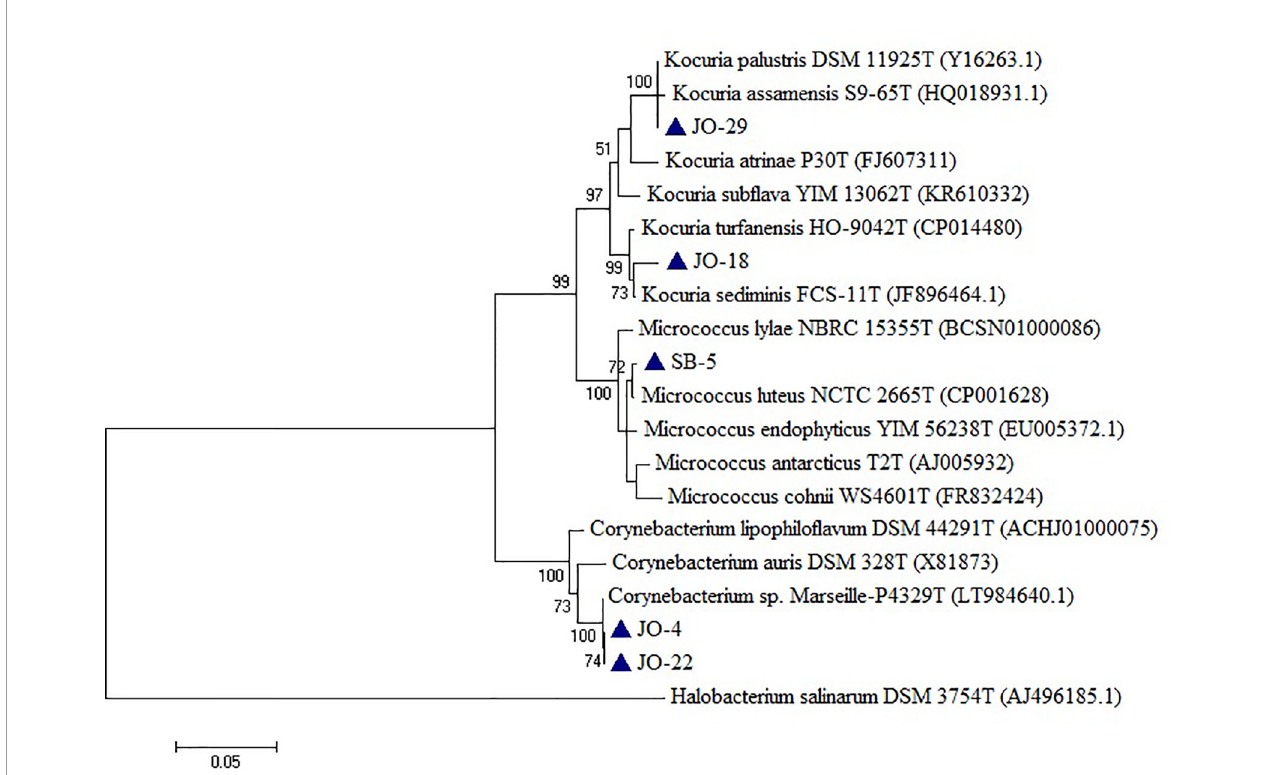
FIGURE 6 | Phylogenetic tree constructed using 16S rRNA gene sequences of LRK isolates belonging to Actinobacteria phylum and closest phylogenetic relatives. The tree was reconstructed by the Maximum Likelihood method using MEGA 6 software. Halobacterium salinarum DSM 3754 T was used as an outgroup. The numbers on the tree indicate the percentages of bootstrap sampling derived from 1,000 replications. Bar, 5 nt substitution per 100 nt. Blue triangles indicates the strains isolated in this